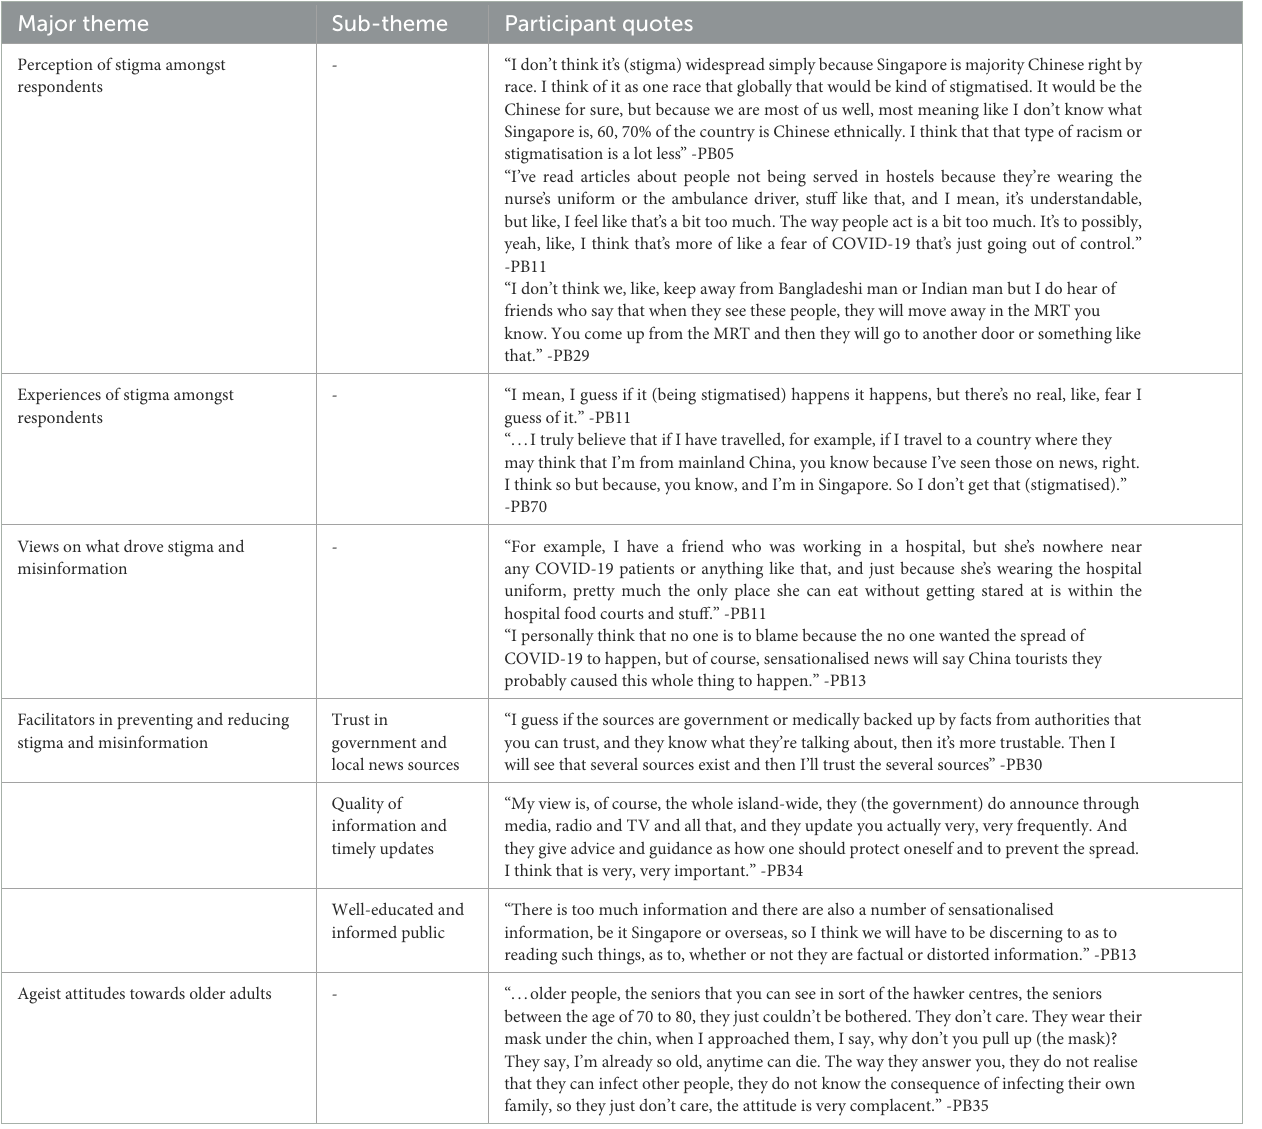
TABLE 2 Major themes, sub-themes, and participant